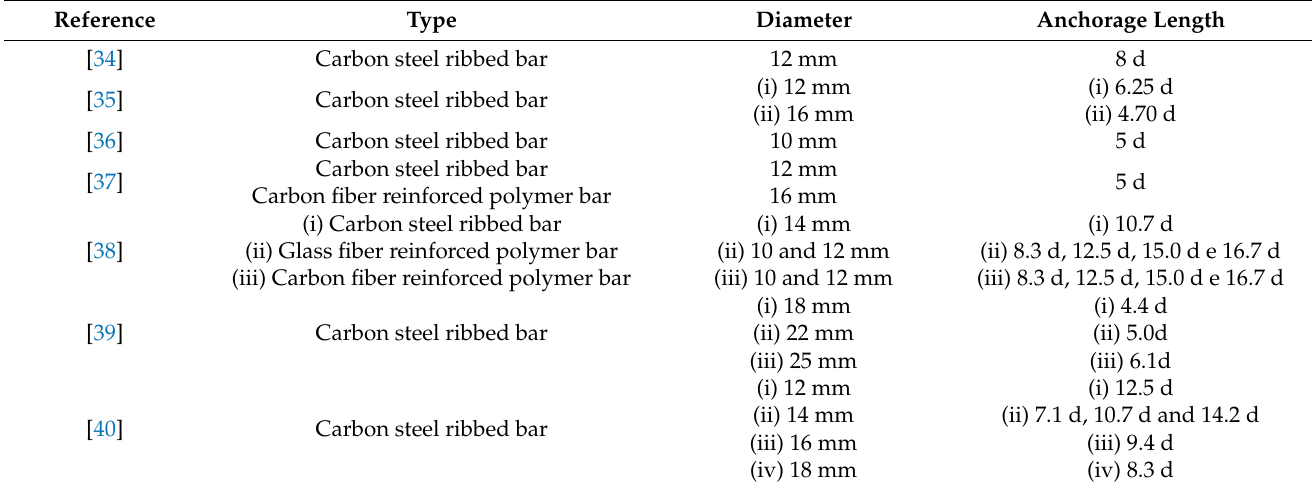
Table 4. Rebar type, diameter, and anchorage